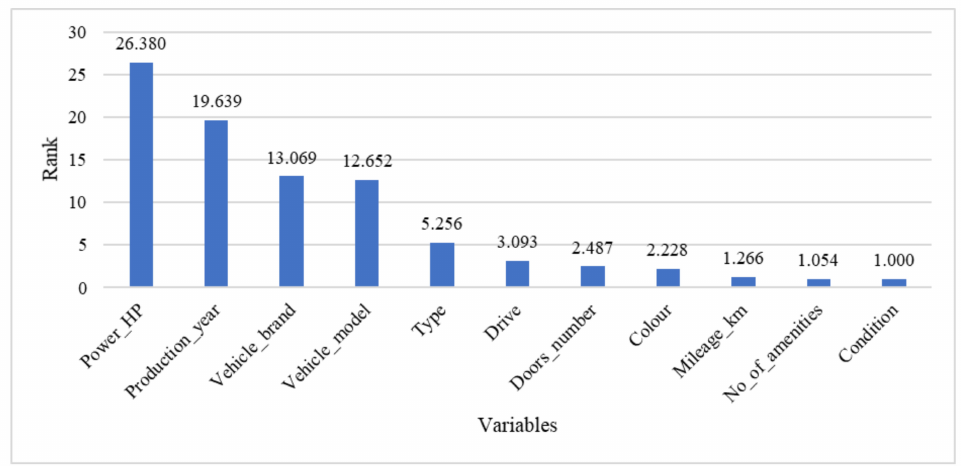
Figure 12. Arithmetic mean values of the importance of variables in the global sensitivity analysis determined based on the best 100 network